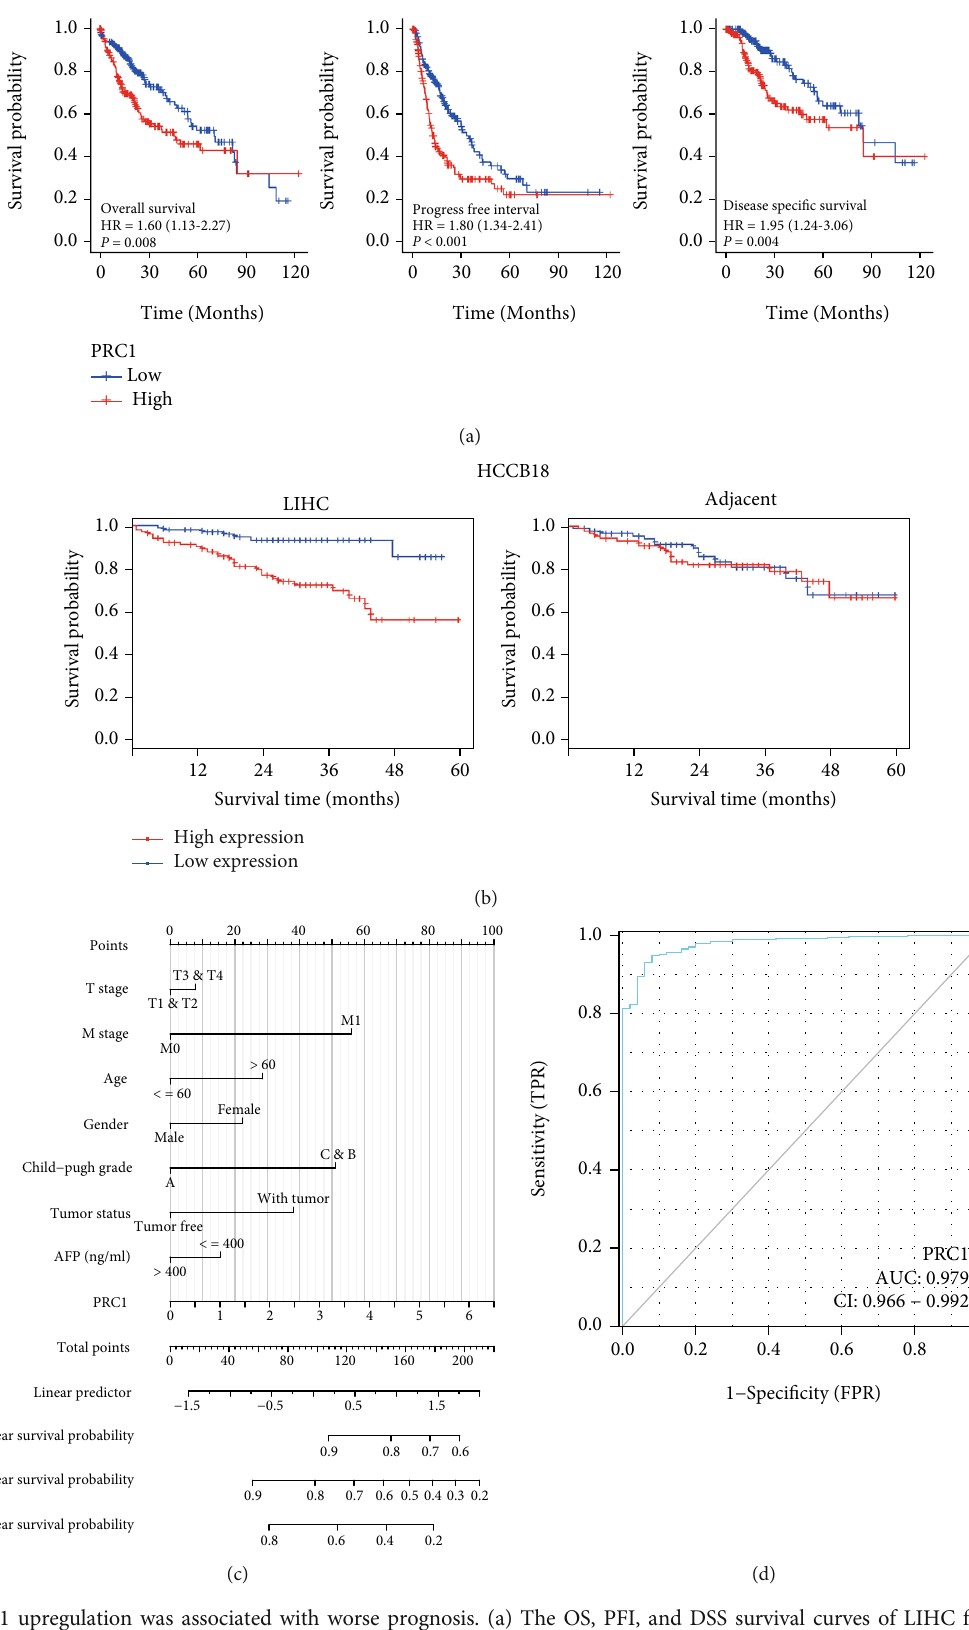
Figure 4: PRC1 upregulation was associated with worse prognosis. (a) The OS, PFI, and DSS survival curves of LIHC from the TCGA database. (b) OS survival curves of LIHC from HCCB18 in the HCCDB database. (c) Nomograms based on clinical factors and PRC1 expression. (d) ROC curve of PRC1. AUC was calculated and